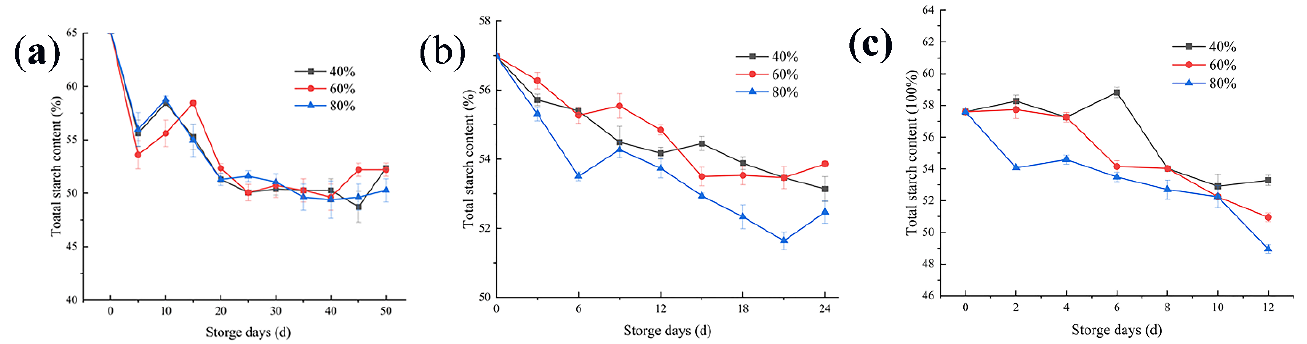
Figure 3. Changes in the total starch content of rice under three different relative humidity conditions at storage temperatures of 20 ( a ), 30 ( b ), and 35 °C ( c ).